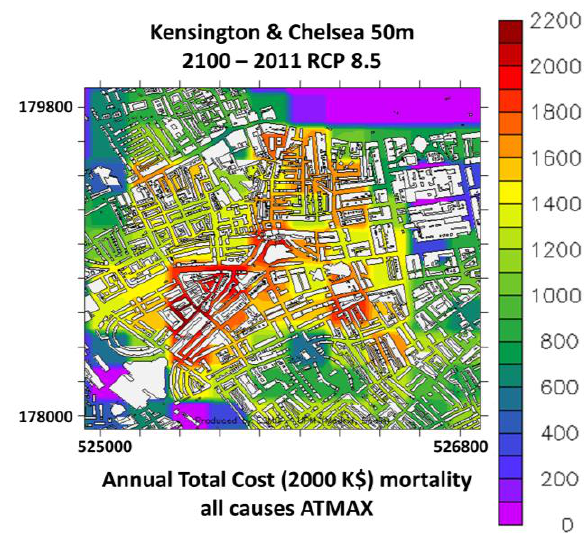
Figure 3. : Spatial distribution of the differences in annual total cost (2000 K$) mortality for 2100 respect to 2011 following RCP 4.5 scenarios with 50 m. of spatial resolution over Kensington and Chelsea.